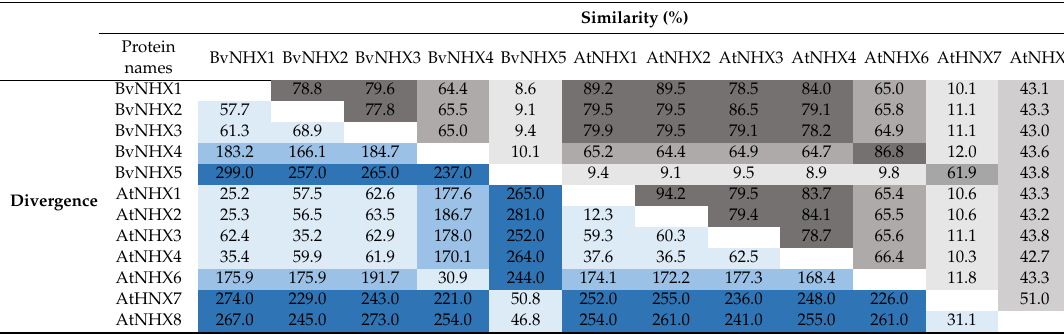
Table 3. Pairwise sequence similarity and divergence among BvNHX and AtNHX proteins. Similarity (%)